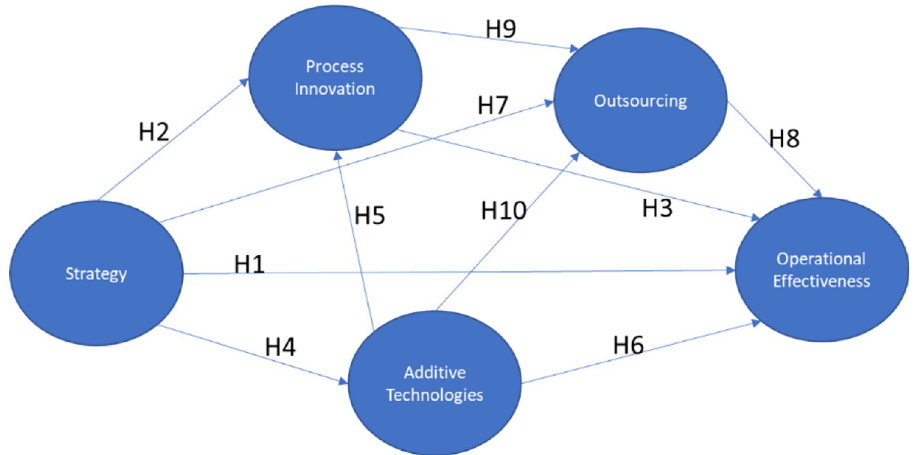
Fig 1. Theoretical model. Source: By the authors.